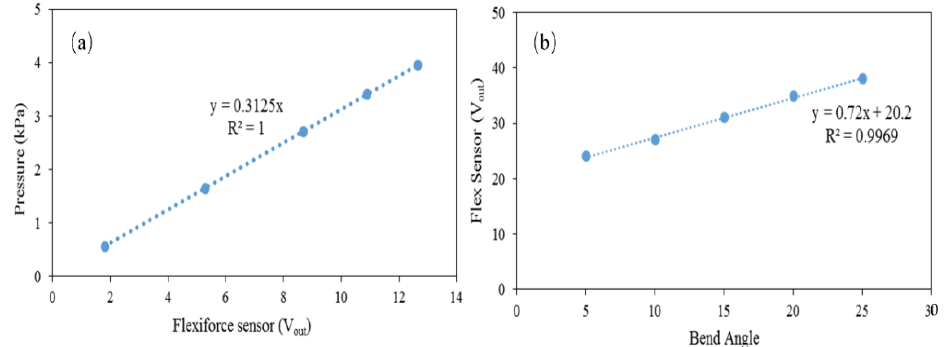
Figure 3. ( a ) A typical relationship between the Flexi force signal change and pressure in the metro- logical characterization. ( b ) Flex sensor response against change in the bend